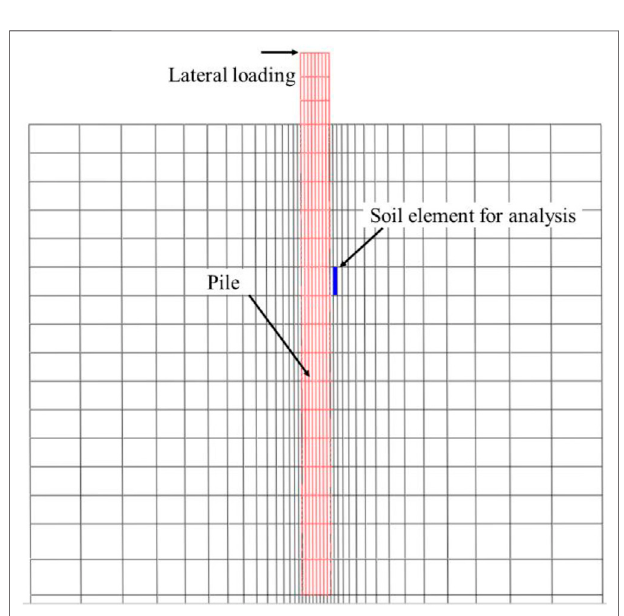
FIGURE 9 | Selected typical soil element around the pile for analysis.